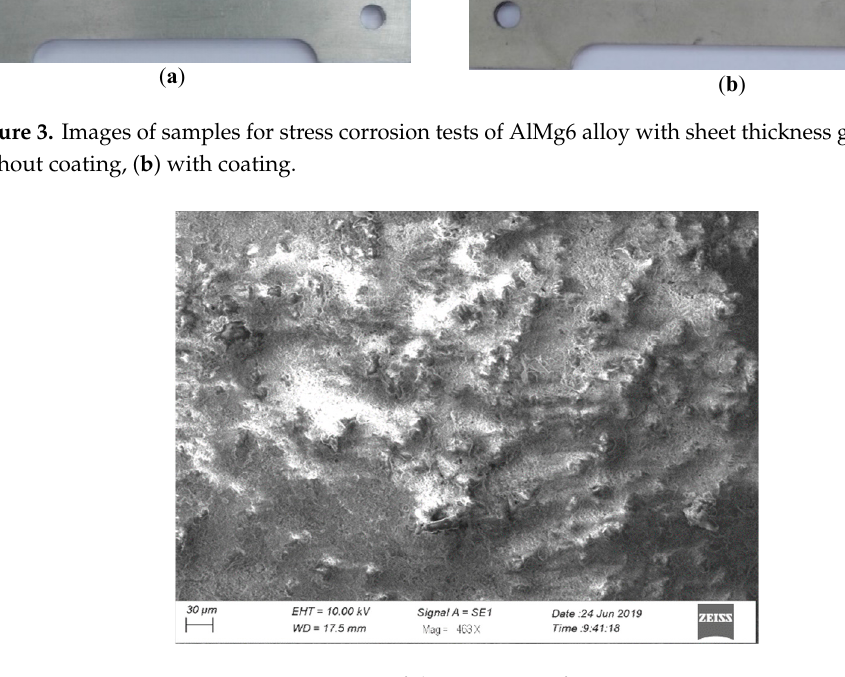
Figure 5. Images of samples after stress corrosion tests of AlMg6 alloy with sheet thickness g = 6 mm, ( a ) without coating, ( b ) with coating, ( c ) without cover after breaking, ( d ) with a coating after breaking.